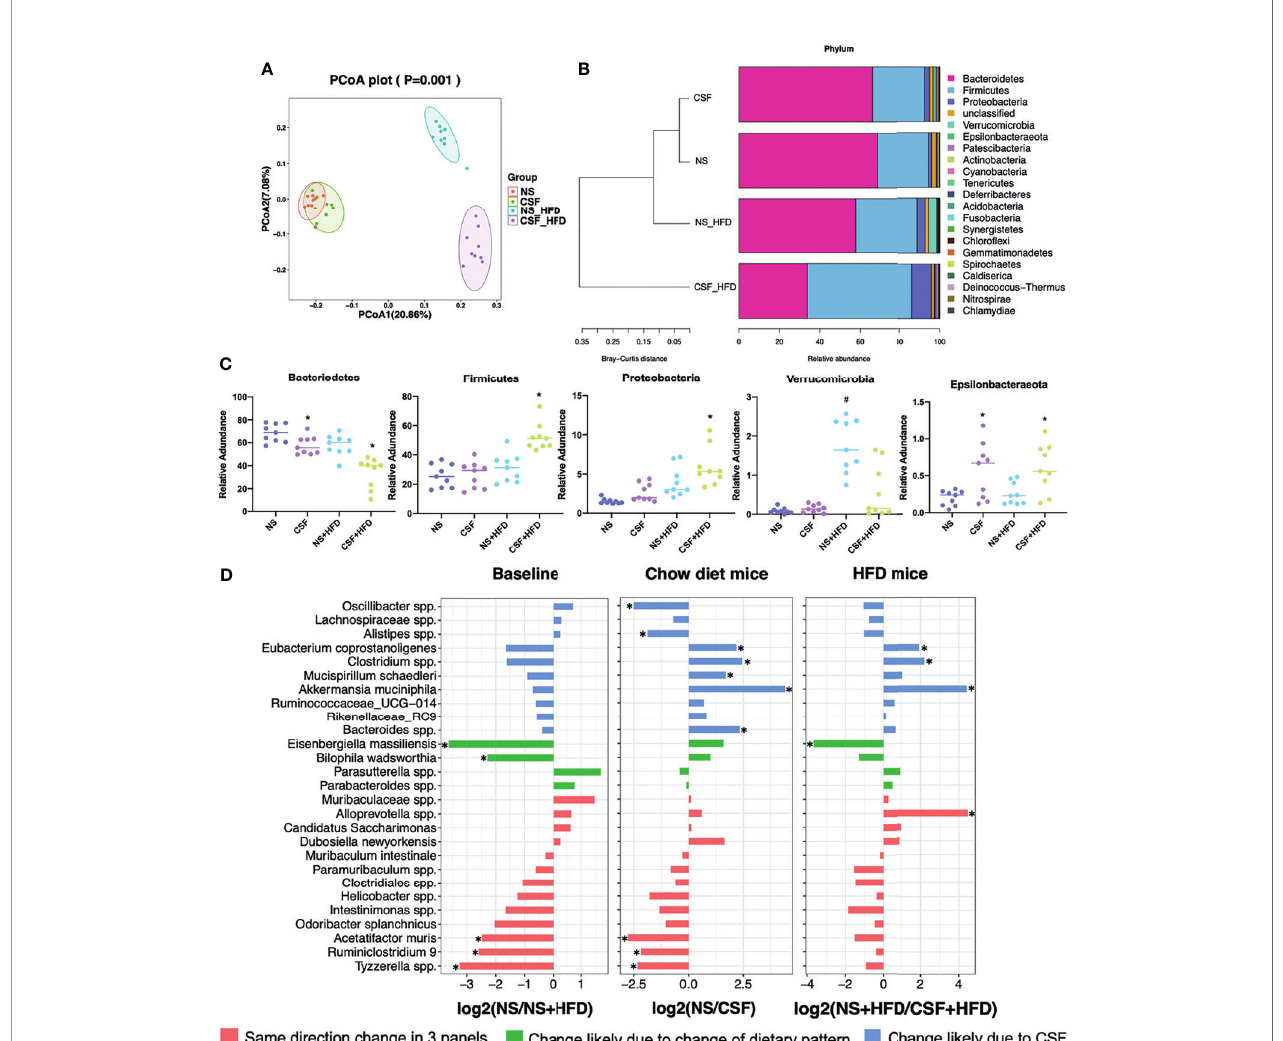
FIGURE 5 | Effects of CSF on fecal microbiota. (A) PCoA plot generated by using microbiota OTU metrics based on the Bray ‐ Curtis similarity for the NS, CSF, NS+HFD, CSF+HFD groups (n = 9/group). (B) The hierarchical cluster based on the Bray ‐ Curtis similarity of the samples from the NS, CSF, NS+HFD, CSF+HFD groups. The bar plot shows the abundance of each phylum in each sample. (C) The 5 most abundant phyla in the NS, CSF, NS+HFD, CSF+HFD groups. Data are expressed as mean ± SEM. Group differences were assessed by using the Mann ‐ Whitney U test. *P < 0.05 when comparing NS vs CSF, or NS+HFD vs CSF+HFD, # P < 0.05 when comparing NS vs NS+HFD. (D) Fold changes of the annotated microbes at the genus level. The data of log 2 FC are expressed as mean. Group differences were assessed by using the Mann ‐ Whitney U test. *P <